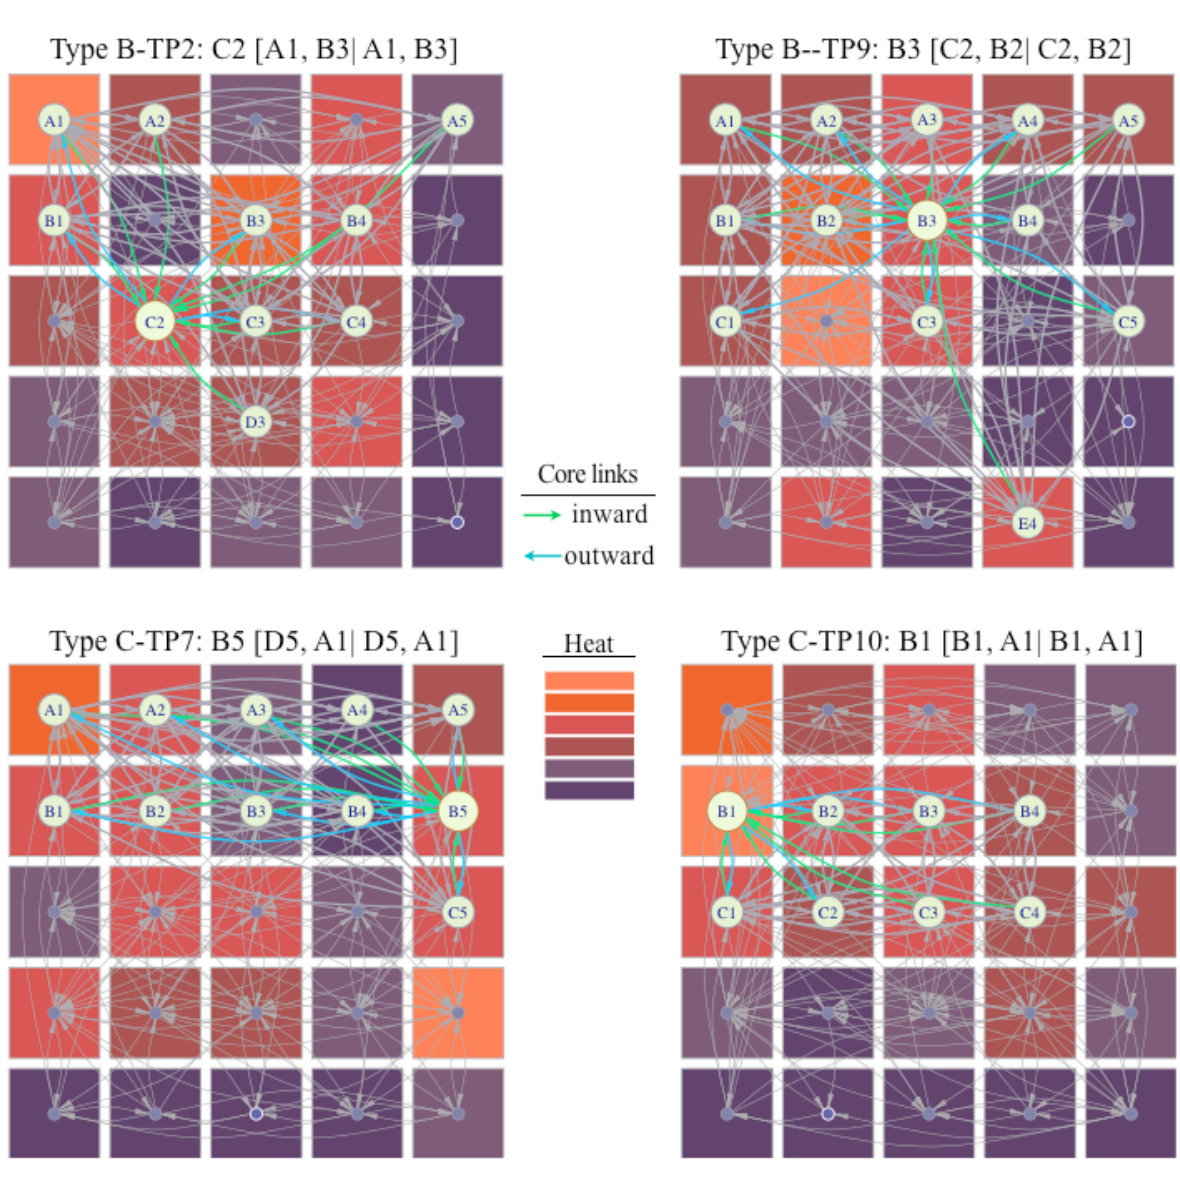
Figure 6. Networks and heat maps by TP of Types B and C with the clique communities highlighted by large and brightly colored nodes with Type-TP labels accompanied by the core node and the primary and secondary hot segments measured by NFix and NLop, i.e., [ NFix 1st, NFix 2nd | NLop 1st , NLop 2nd ]. [Note] Segments are colored by heat grade listed in Table 2 .